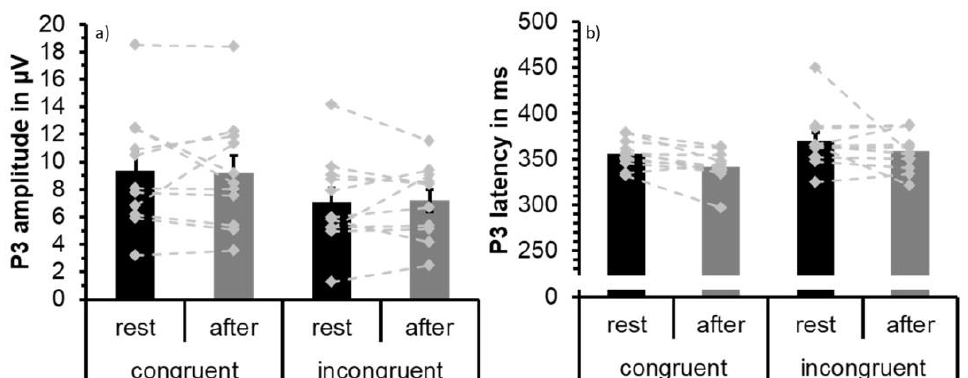
Figure 7. Mean P3 peak amplitude ( a ) and peak latency ( b ) averaged across participants (N = 11) and across parieto-central electrode sites (P3, Pz, P4, CP1, CP2, Cz) to congruent and incongruent trials at rest (black) and following acute exercise at moderate intensity (grey). Error bars depict standard error values. The DotPlot visualizes the individual data (light grey) for the congruent and incongruent condition as well as the change from rest to after-exercise (dashed lines).